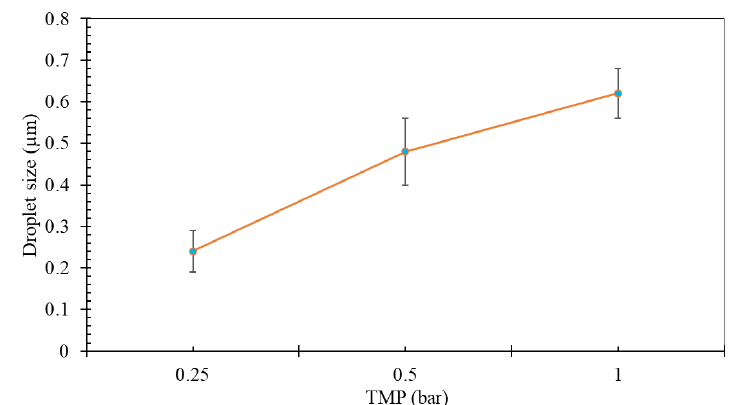
Figure 3. Average droplet size as function of applied pressure.